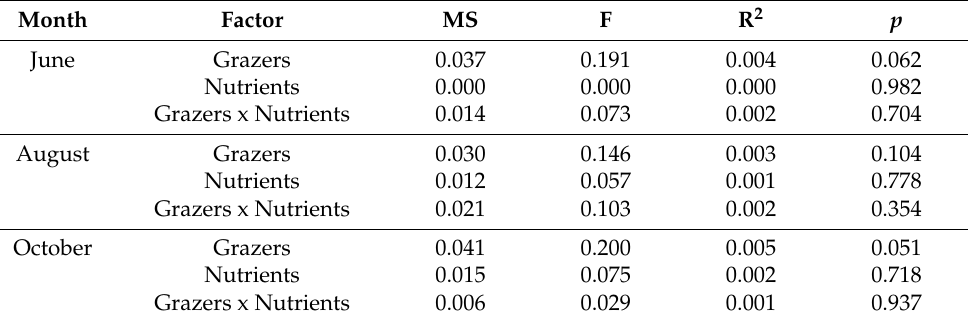
Table 3. Results of nested two-way PERMANOVAs conducted separately in June, August, and October, testing the effects of enhanced grazers and enhanced nutrients, nested within lake, on microplankton assemblage